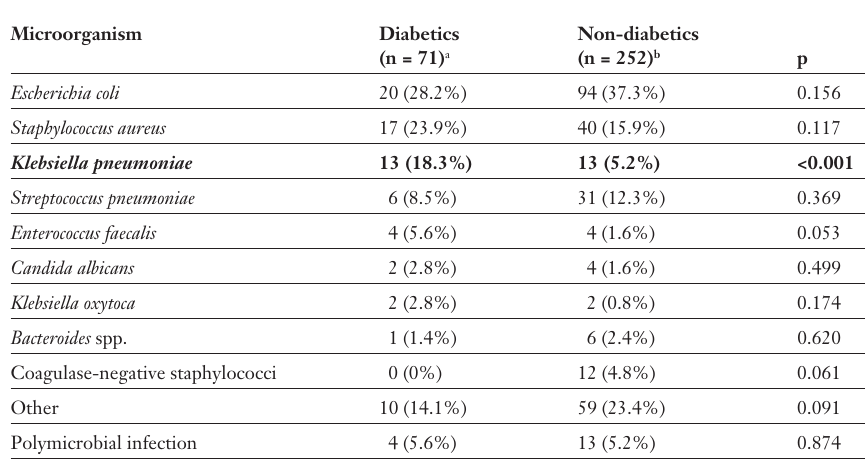
Microorganisms isolated from blood